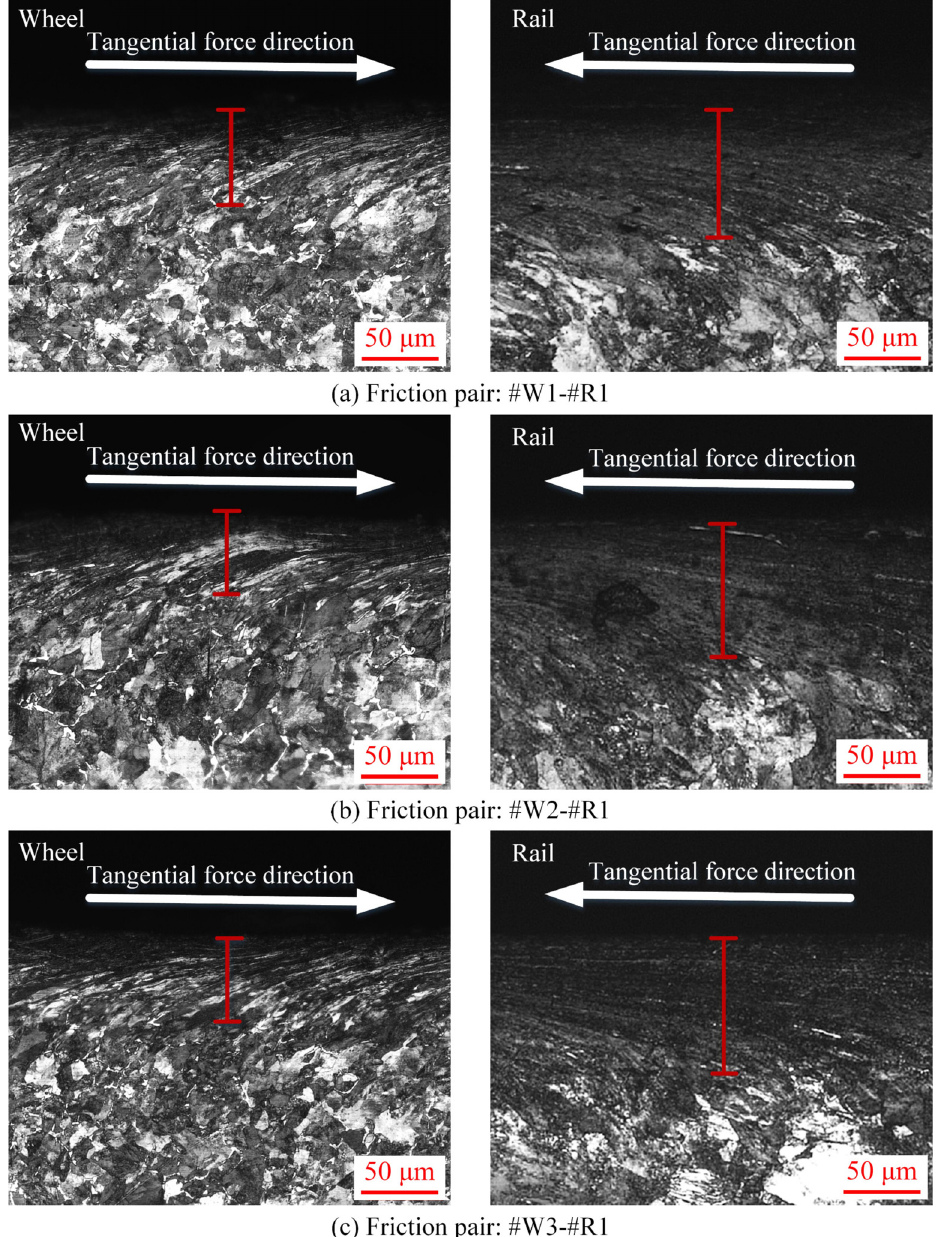
Figure 14. OM micrographs of subsurface plastic deformation of the wheel / rail discs under di ff erent friction pairs: ( a ) #W1-#R1; ( b ) #W2-#R1; ( c )